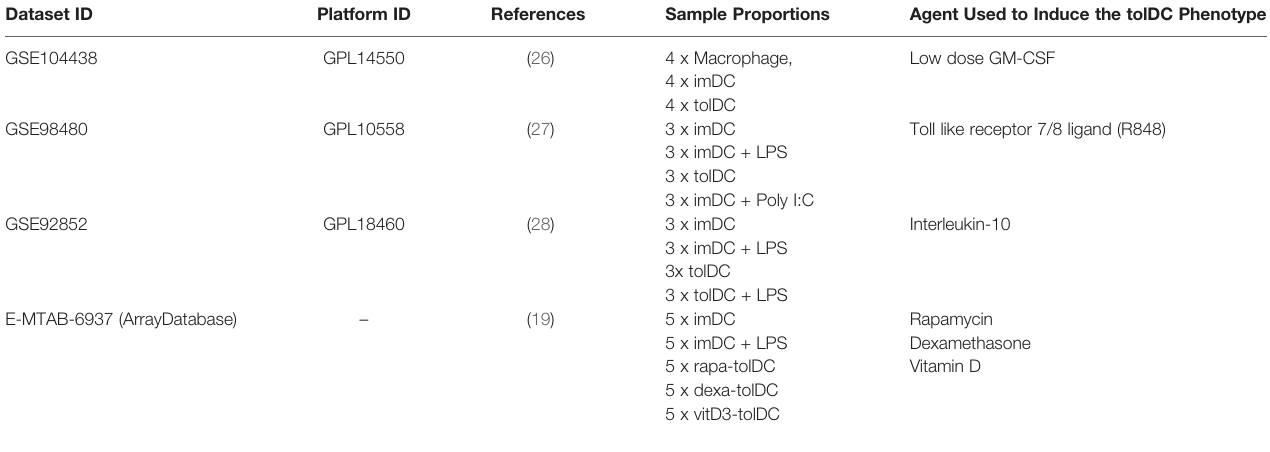
TABLE 4 | Identi fi ed publicly available gene datasets including immature, tolerogenic and mature DC for tolDC gene set